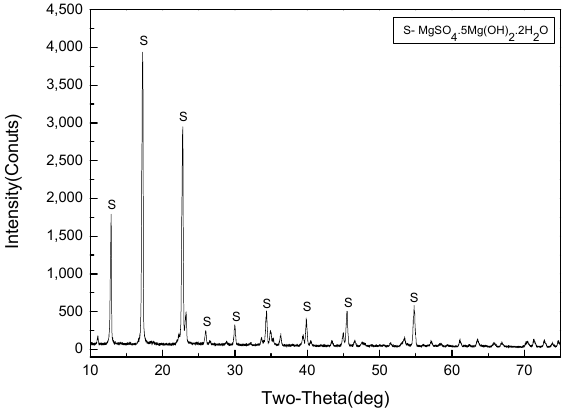
Figure 15. XRD pattern of the hydrothermal product.